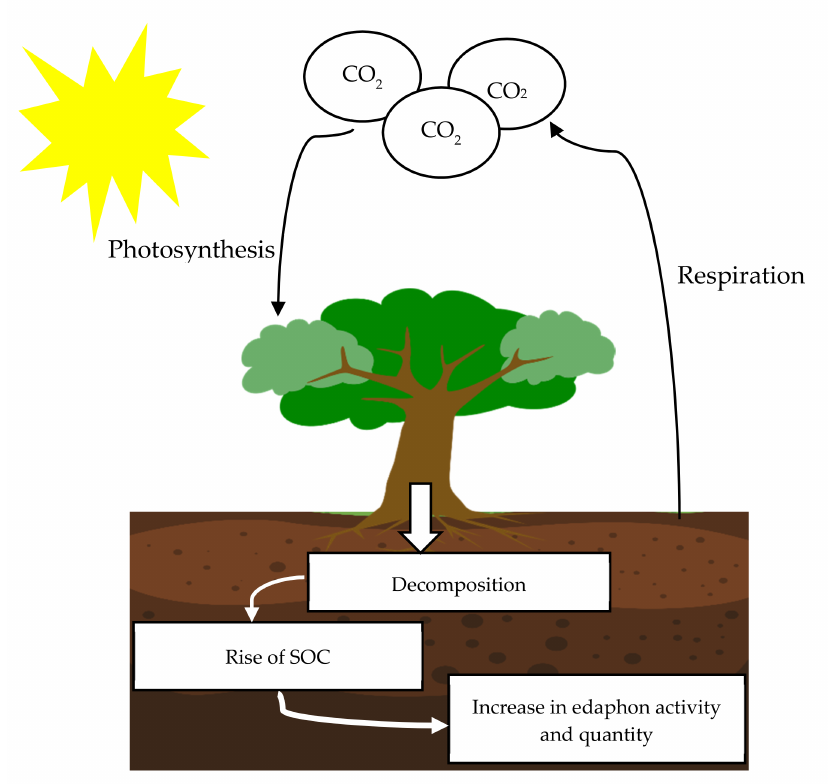
Figure 4. Simplified scheme for the fate of CO 2 in air-soil medium sequestrated by photosynthesis. Soil contains the biggest terrestrial reservoir of carbon, and soil carbon constitutes approximately two-thirds of total carbon in ecosystems [36,115]. The organic carbon content in the topsoil in selected countries (Figure 5) is shown by de Brogniez et al.